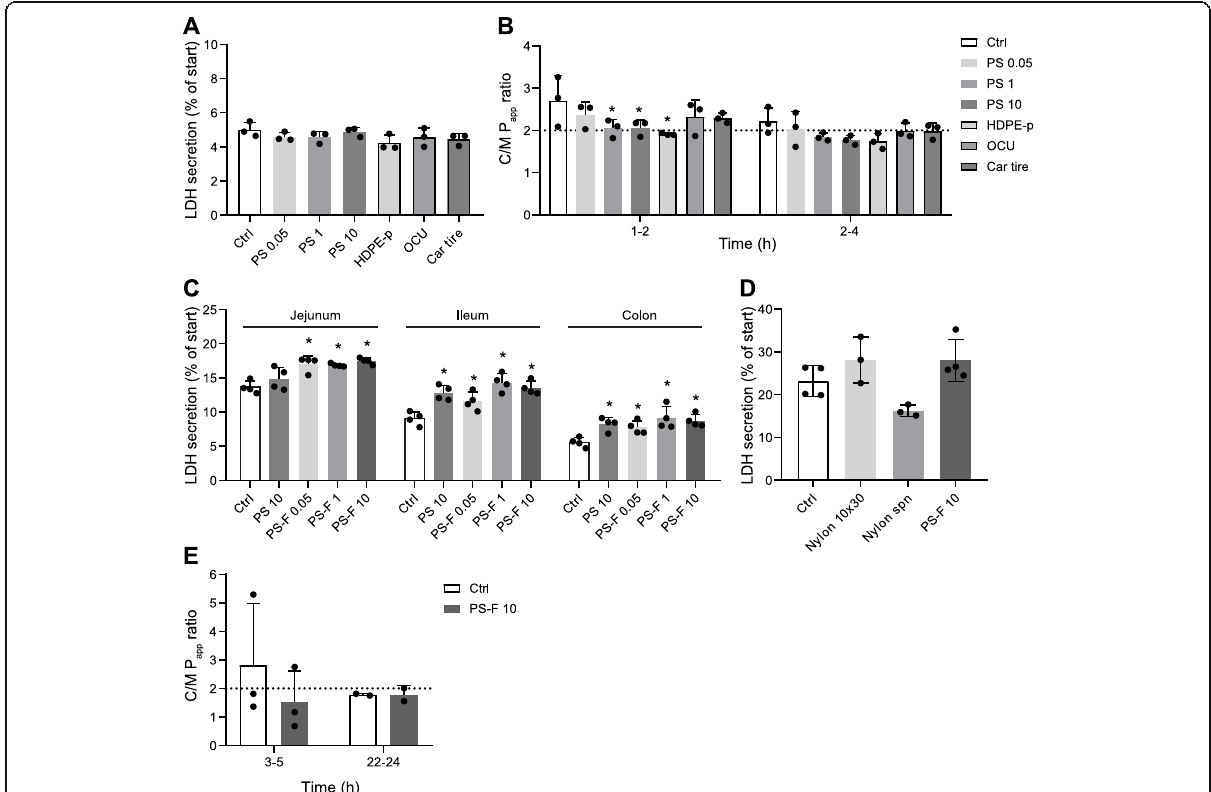
Fig. 3 Viability and functionality of human and porcine intestinal tissue explants upon exposure to MNP (1 mg/mL). A-B Human colon tissue explants were mounted in the InTESTine ™ and exposed to MNP for 4 h ( n = 3). A Cumulative LDH release into the apical and basolateral compartment. B Ratio of caffeine/mannitol (both applied at 10 μ M) apparent permeability (P app ), calculated between 1 and 2 and 2 – 4 h of incubation. Cutoff for proper tissue functionality is 2, indicated by the dotted line. C Cumulative LDH release into the apical and basolateral compartment of porcine jejunum, ileum and colon tissue explants mounted in the InTESTine ™ and exposed to MNP for 5 h ( n = 4). D-E Control and PS-F 10 exposed porcine colon tissue explants in the Intestinal Explant Barrier Chip (IEBC) for 24 h (n = 3 – 4). D Cumulative LDH release into the apical and basolateral compartment. E Ratio of caffeine/mannitol (both applied at 10 μ M) P app , calculated between 3 and 5 and 22 – 24 h of incubation. Cutoff for proper tissue functionality is 2, indicated by the dotted line. Data are presented as mean ± SD. * p < 0.05 compared to the control condition, calculated by one-way ANOVA (Dunnett ’ s multiple